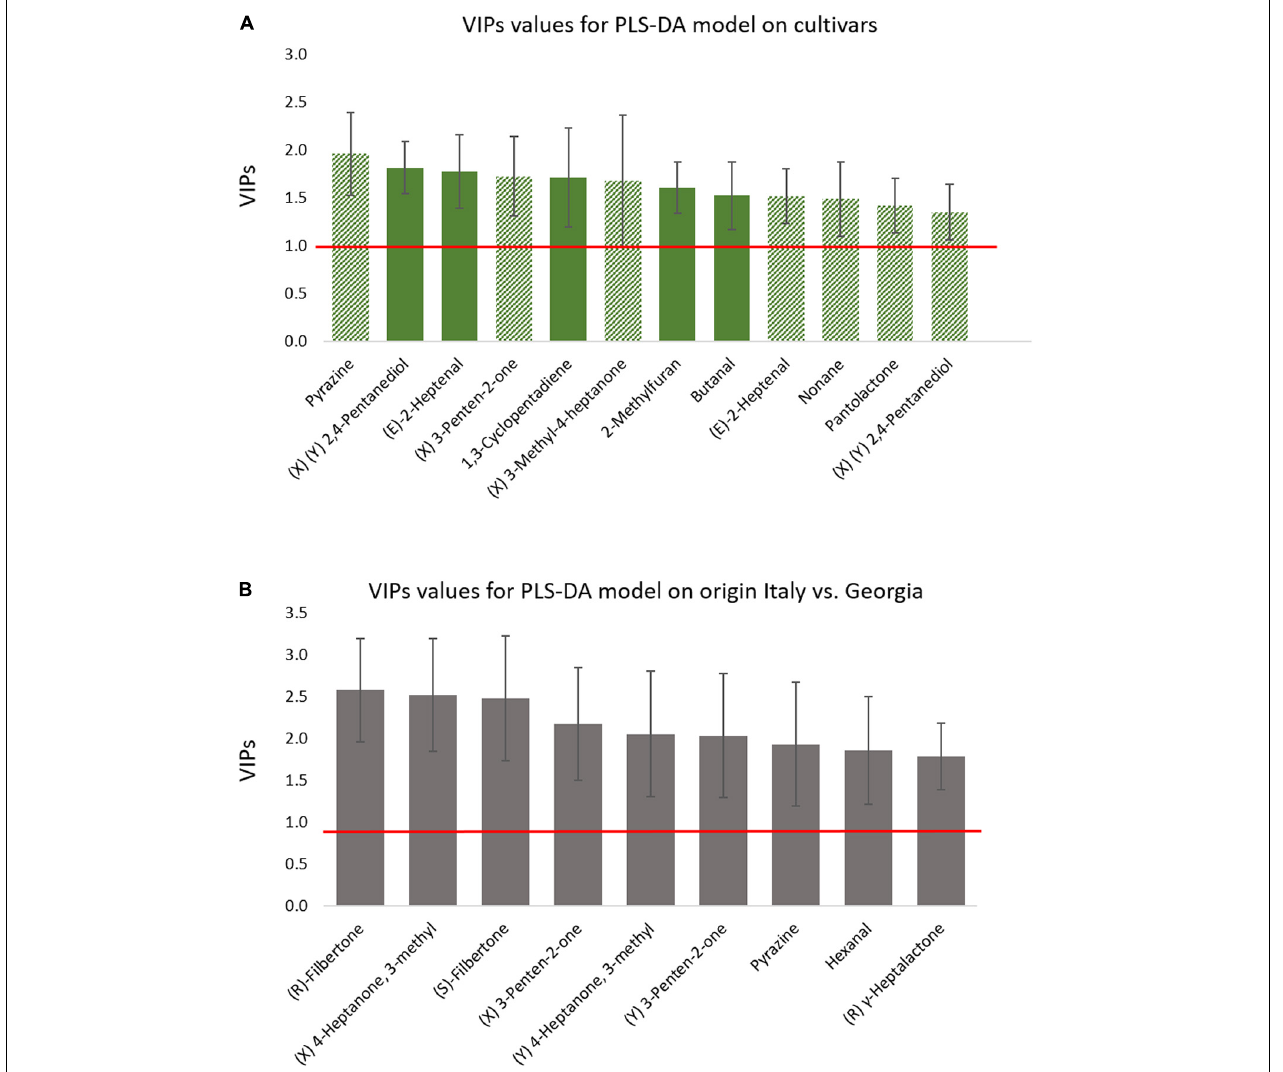
FIGURE 4 | Variable importance in projection (VIP) scores deriving from the PLS-DA based on classification model for roasted samples discriminated for cultivars (A,B) origin. Only VIP ± SD > 1 are reported. Bar coloring in (A) relates to variables discriminating along the first component (t1-plain color) or along the second (t2—shaded